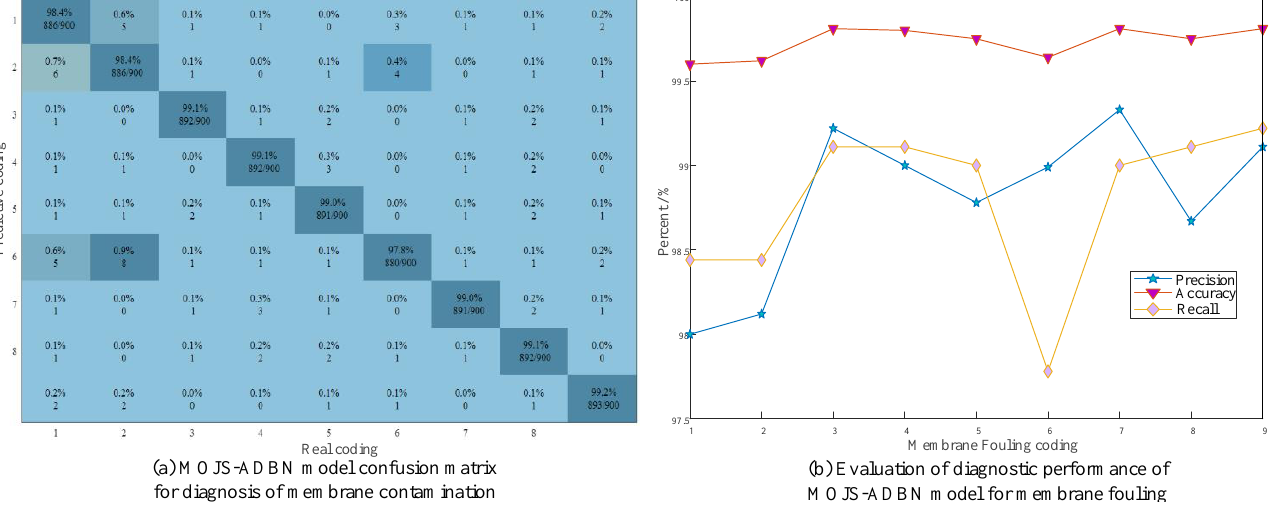
Figure 8. Comparison of optimization weights of different learning rates.